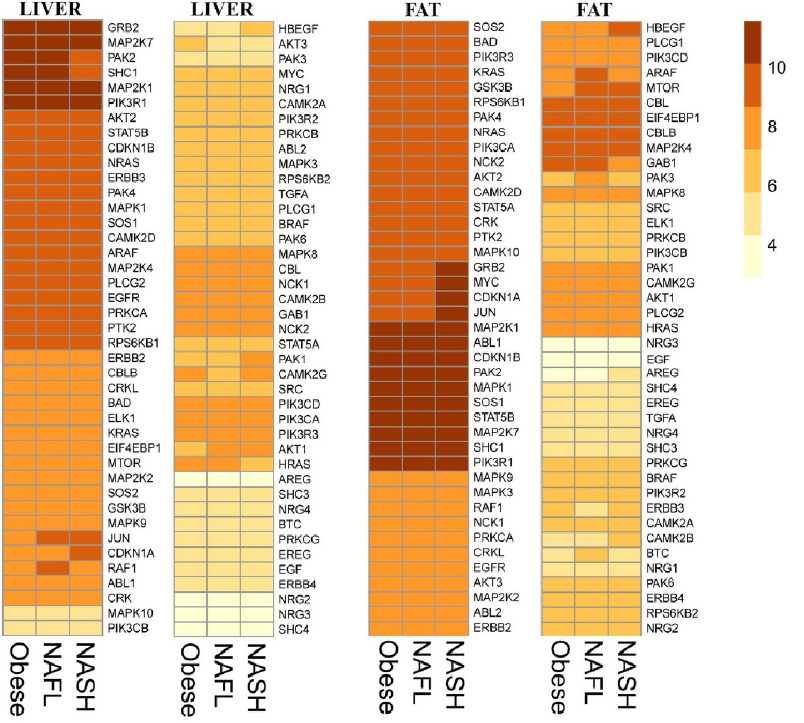
Fig 3. Heatmap of 82 NrG4-ErbB signalling pathway related genes. Visualised as average Robust Multi-array Average (RMA) expressions in the liver and visceral adipose tissue of obese, NAFLD and NASH patients.